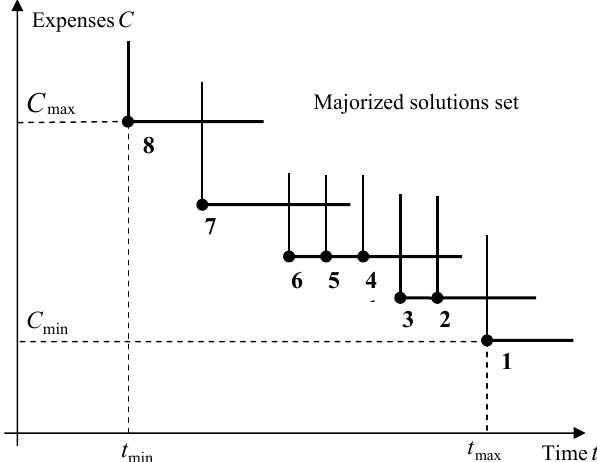
Fig.1: Pareto‐optimal solutions (1, 3, 6, 7, 8) of the transportation problems by criteria of expenses and time